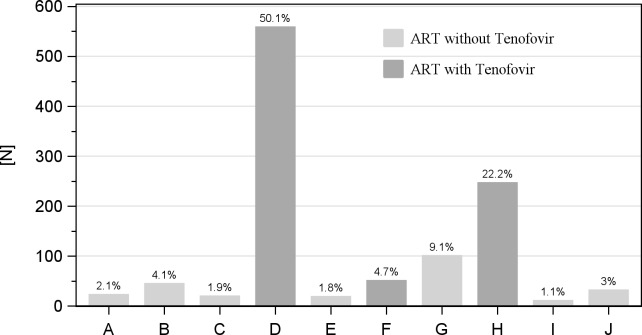
ARTs regimen as documented at time of last creatinine measurement.A = Stavudine (d4T), 3TC, Nevirapine (NVP); B = AZT, 3TC, Efavirenz (EFV); C = Abacavir (ABC), 3TC, EFV; D = TDF, Emtricitabine (FTC), EFV; E = ABC, Lopinavir (LPV), Ritonavir (rtv); F = TDF, FTC, LPV/rtv; G = AZT, 3TC, NVP; H = TDF, FTC, NVP; I = ABC, 3TC, NVP; J = not classifiable/other combinations.